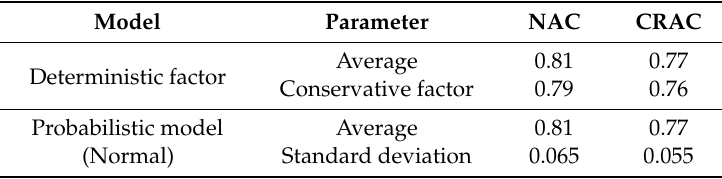
Table 5. Proposed deterministic and probabilistic models of